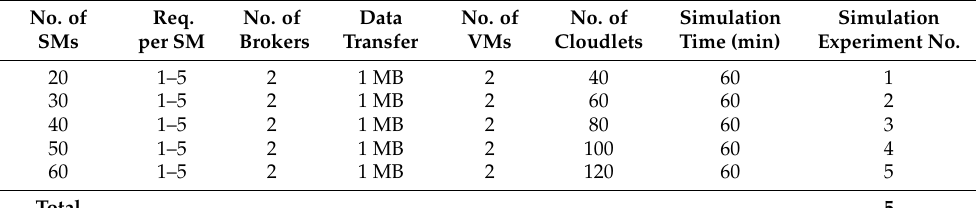
Table 5. Detailed configuration of simulation experiments.